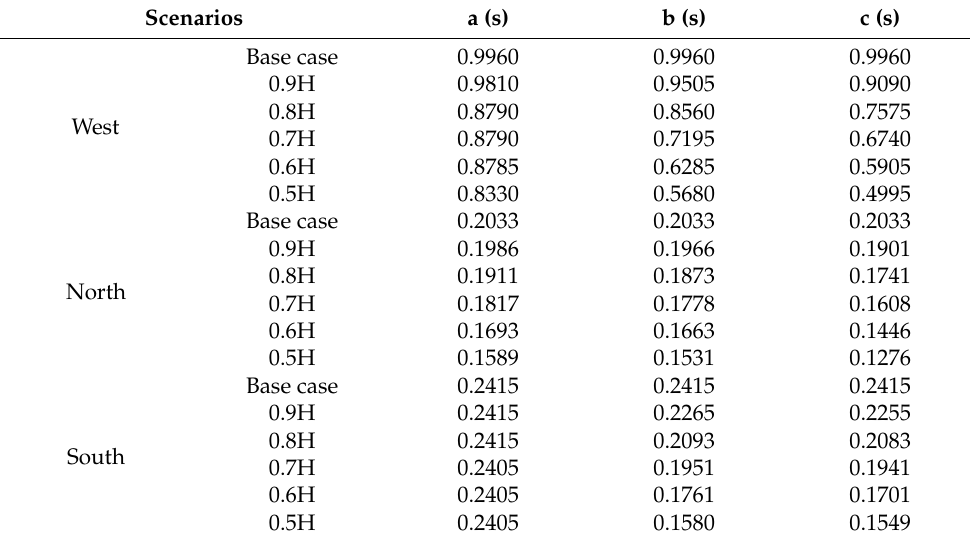
Table 2. CCTs in different areas of 33-bus New England system at different scenarios.